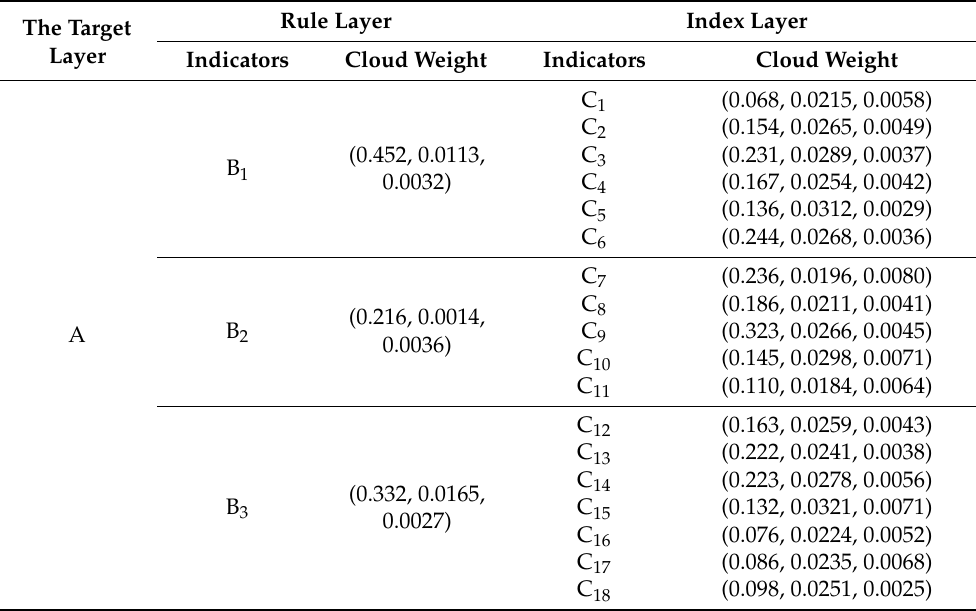
Table 3. Urban stormwater resilience assessment index system cloud weight.